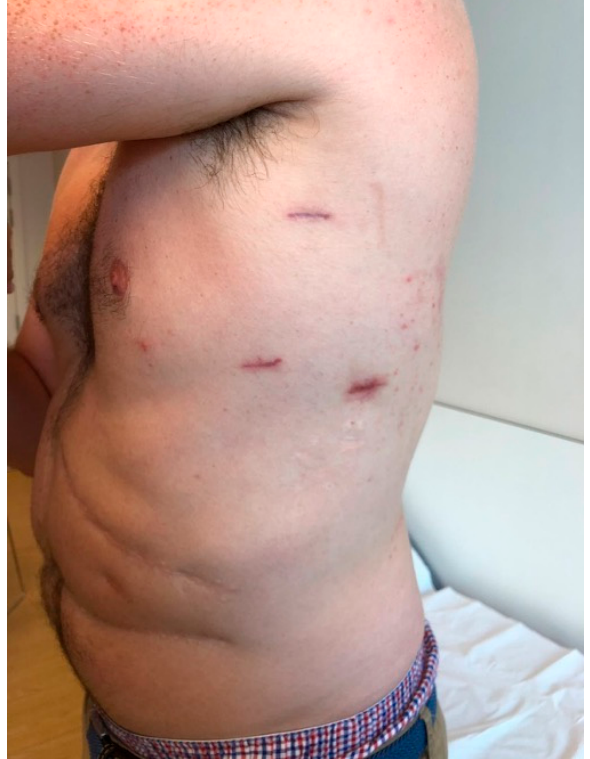
Figure 6. Anterior trocar access scars.